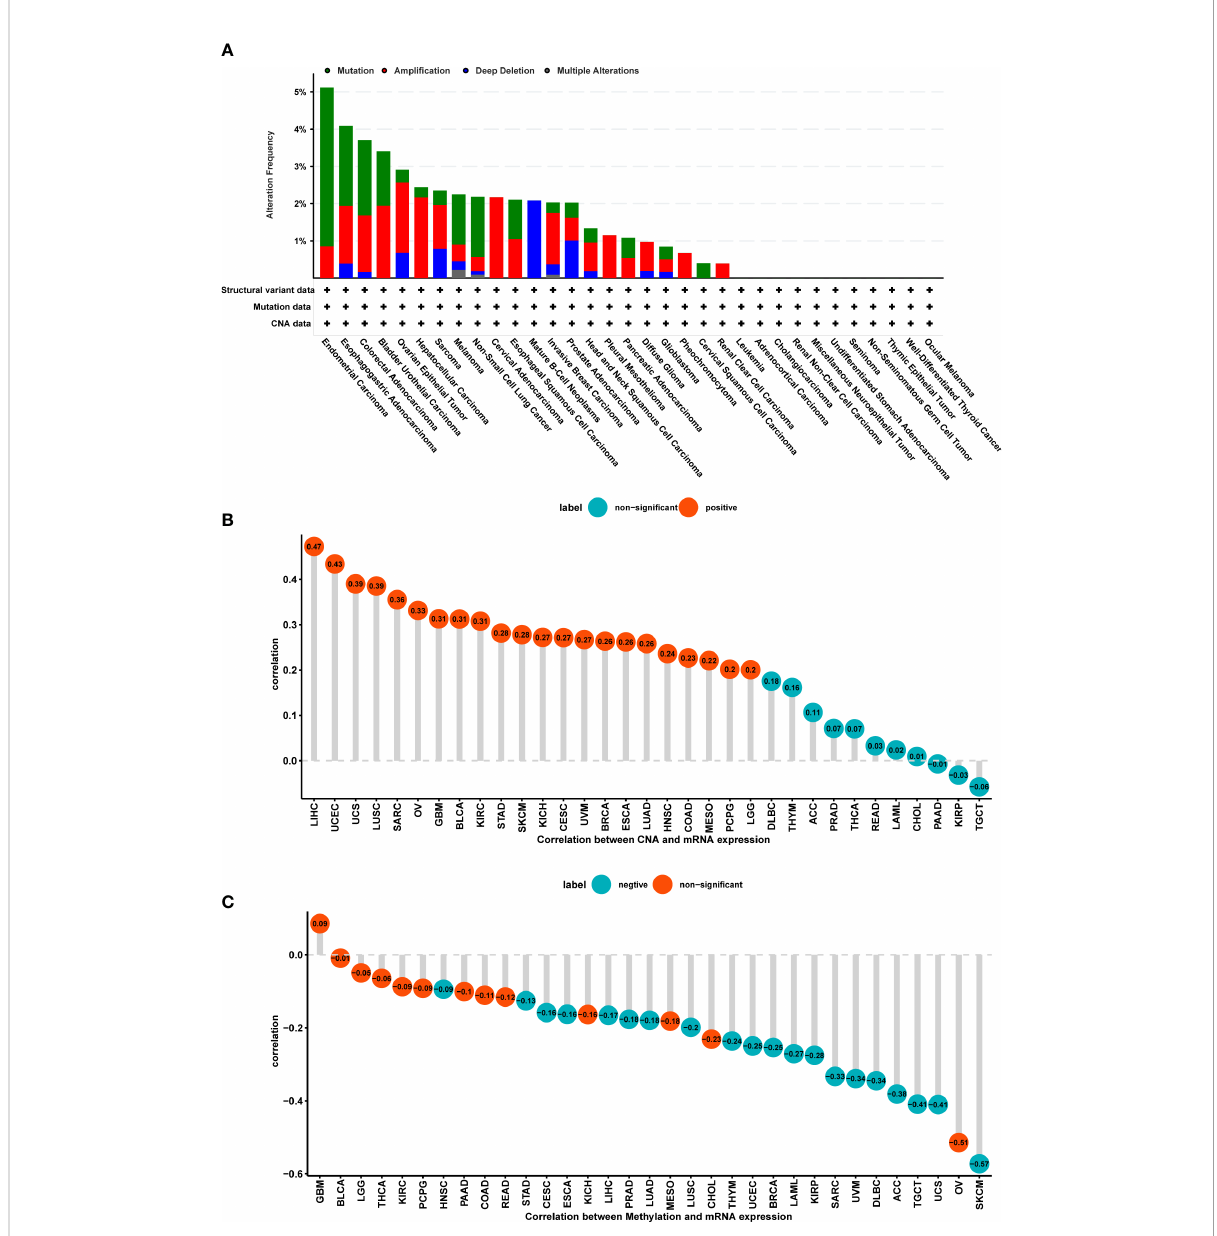
FIGURE 2 The role of POGLUT2 in gene mutation and ampli fi cation, methylation, and copy number alterations (CNAs). (A) . Ratio of gene mutation (green), ampli fi cation (red), deep deletion (blue), and multiple alterations (gray) in different types of tumors. (B) Correlation between CAN and POGLUT2 expression. Signi fi cant positive correlations were found in LIHC, UCEC, UCS, LUSC, SARC, OV, GBM, BLCA, KIRC, STAD, SKCM, KICH, CESC, UVM, BRCA, ESCA, LUAD, HNSC, COAD, MESO, and PCPG, whereas no correlation was found in LGG, DLBC, THYM, ACC, PRAD, THCA, READ, LAML, CHOL, PAAD, KIRP, and TGCT. (C) Correlation between methylation and POGLUT2 mRNA expression. Signi fi cant negative correlations between methylation and POGLUT2 mRNA expression were found in HNSC, STAD, CESC, ESCA, LIHC, PRAD, LUAD, LUSC, THYM, UCEC, BRCA, LAML, KIRP, SARC, UVM, DLBC, ACC, TGCT, UCS, and SKCM, but not in other types of